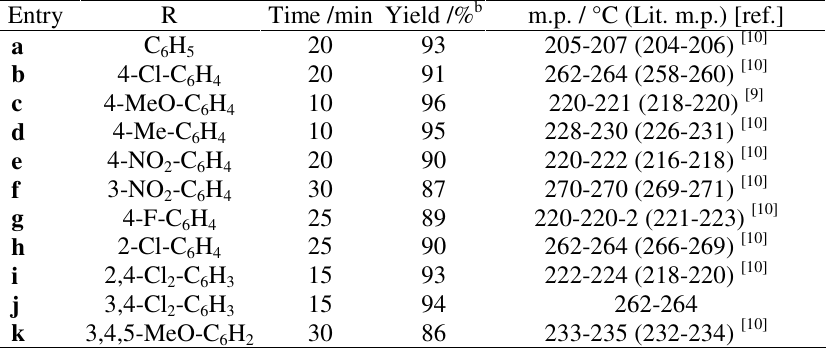
Table 3. Synthesis of 2 H -indazolo[2,1- b ]phthalazine-1,6,11(13 H )-trione derivatives